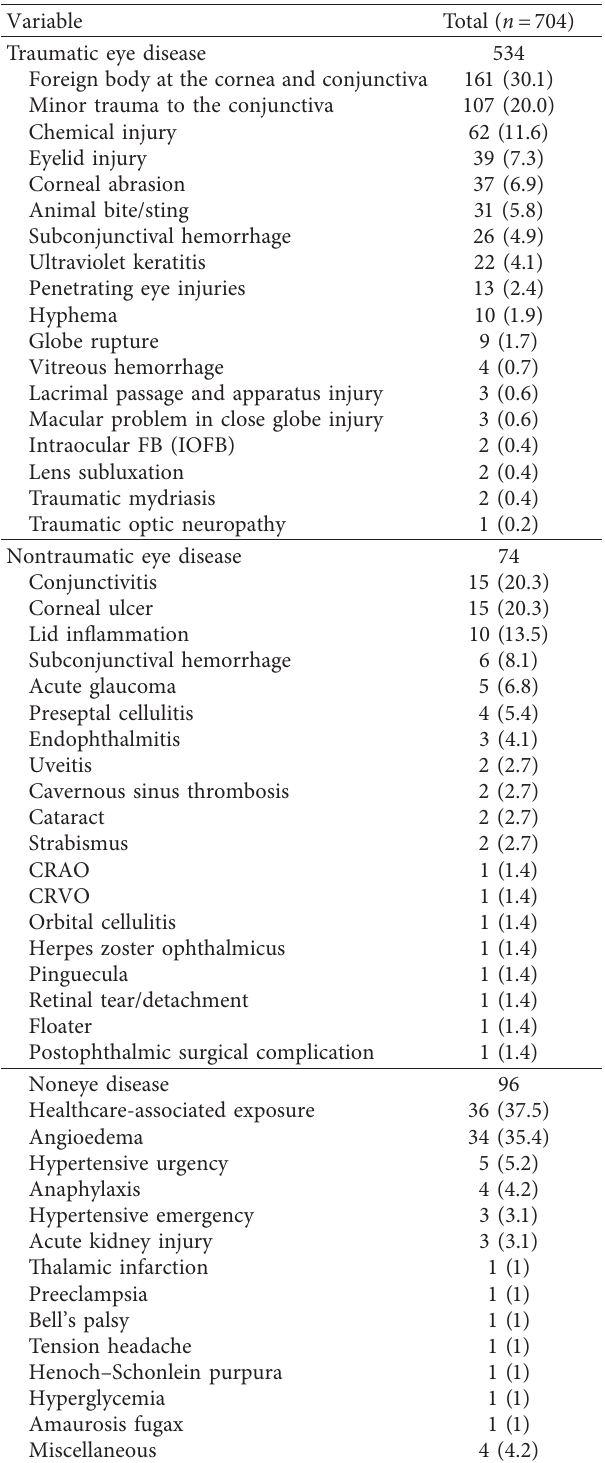
Table 2: Proportions of patients with eye-related chief complaints classified by groups of